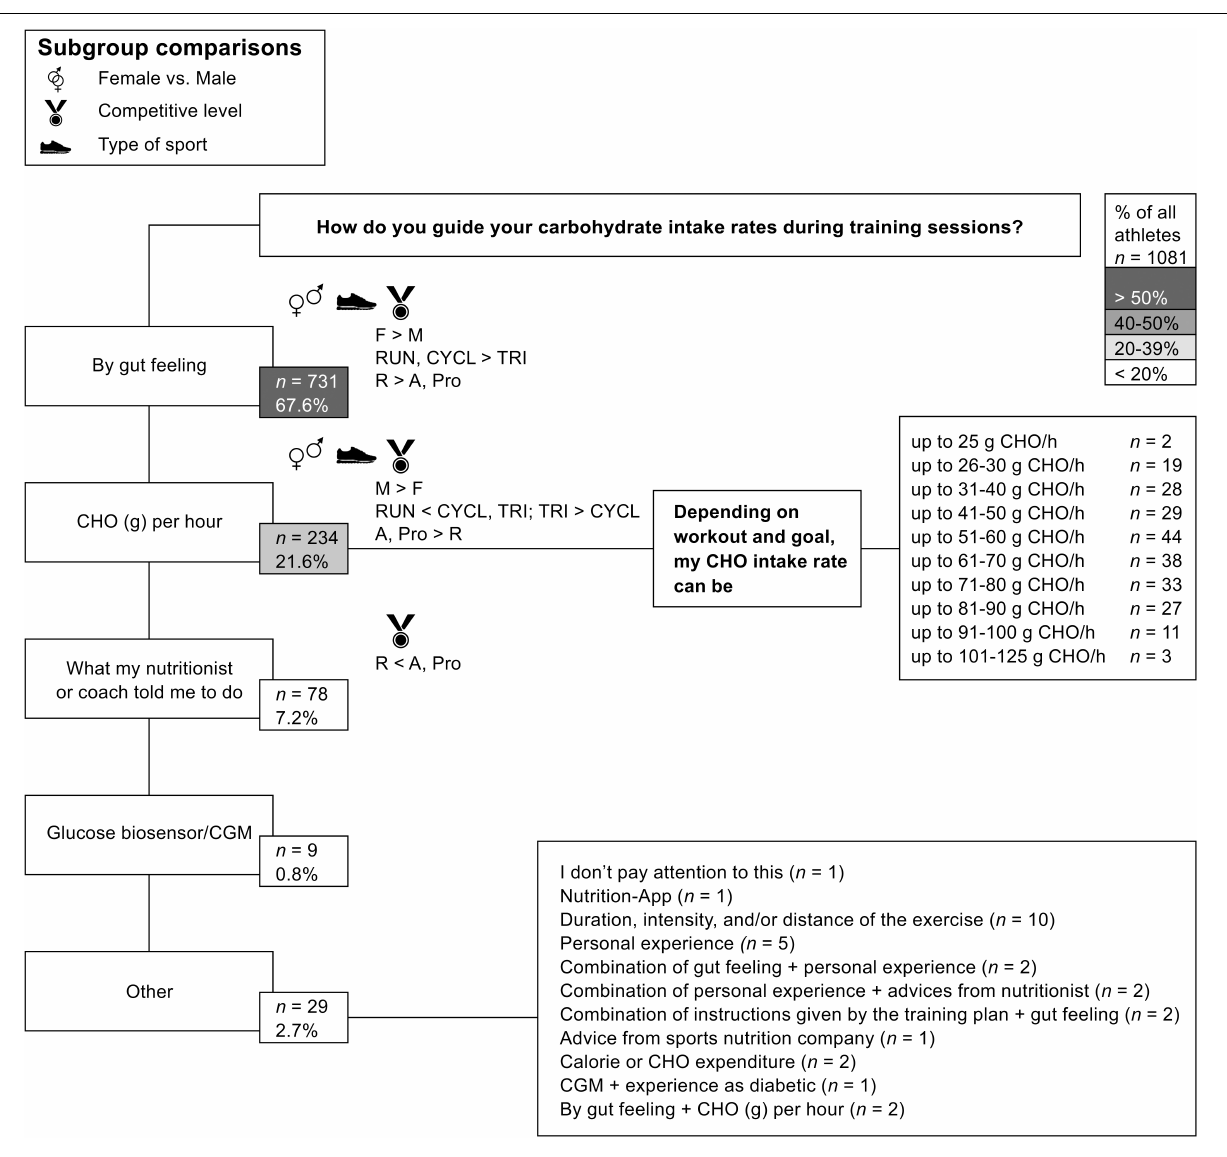
FIGURE 3 | Applied carbohydrate (CHO) intake rate practices during training sessions among endurance participants ( n = 1,081). CGM, continuous glucose monitoring. Significant differences between subgroups ( p < 0.05) are depicted with symbols and a brief description of the direction of the differences. F, female; M, male; R, recreational; A, amateur; Pro, professional; RUN, running; CYCL, cycling; TRI,